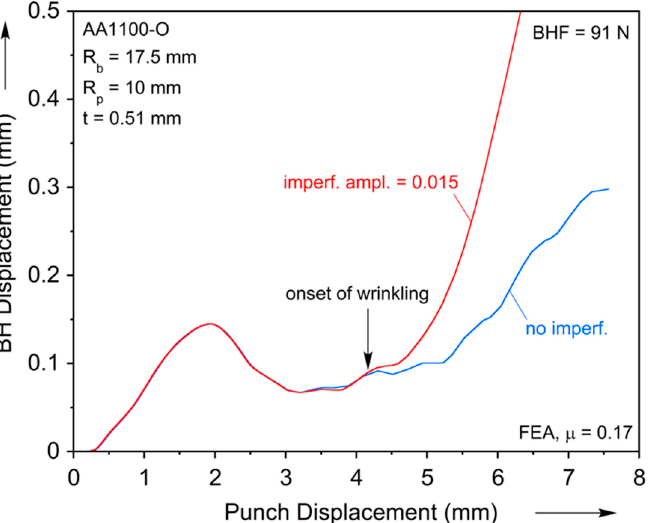
Figure 14. Blankholder displacement vs. punch displacement for simulated cups with or without imperfection under 91 N BHF. The deviation between the two curves is used to identify the onset of wrinkling.